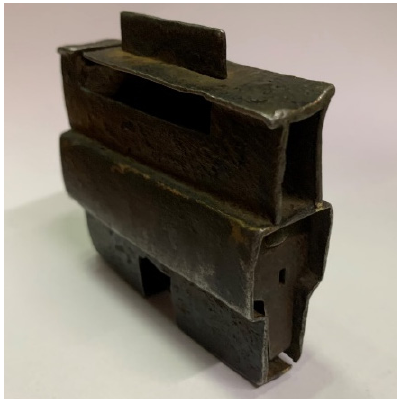
Figure 9. Ancient Tibetan lock used as a sample.